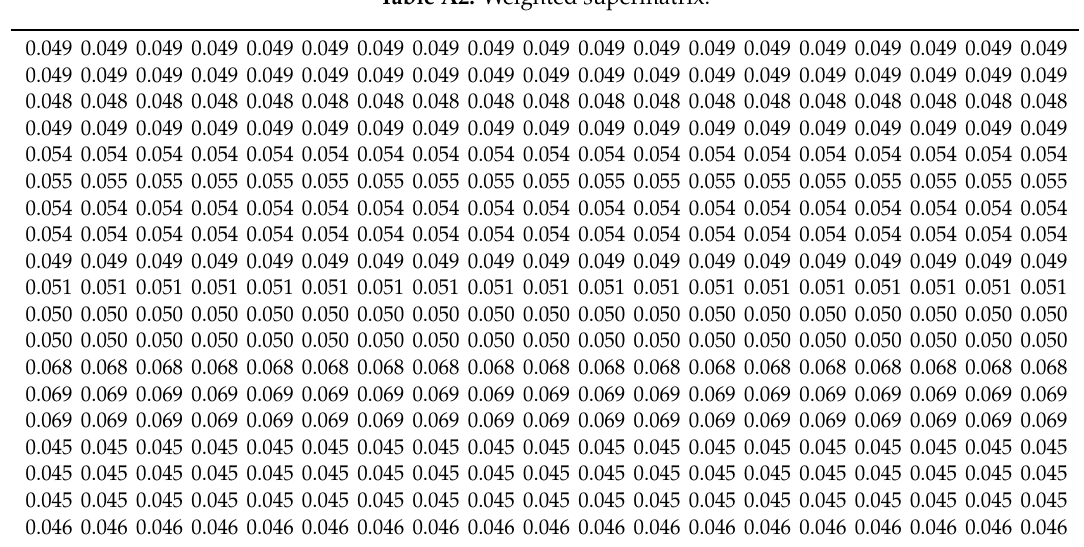
Table A2. Weighted supermatrix.